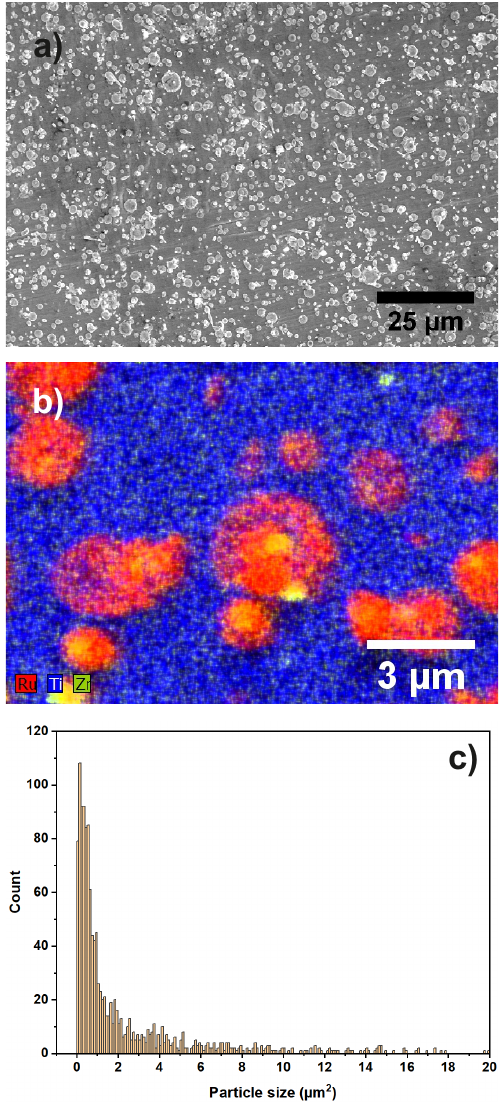
Figure 18. ( a ) SEM overview image of sample “Ru/Ti-3”. Different shapes and sizes of catalyst particles are visible; ( b ) EDX map of several Ru and Zr particles on the Ti support; ( c ) particle size distribution of the catalyst